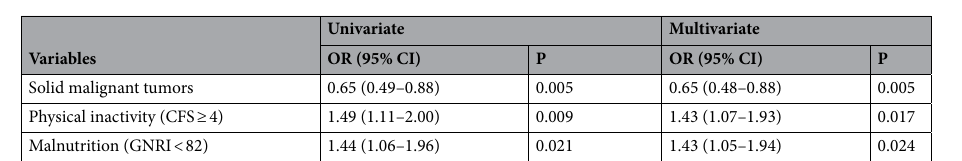
Figure 2. ( A ) Survival according to phenotypes of frailty. There was a significant difference in the cumulative survival possibility among the four phenotypes. ( B ) Home discharge according to phenotypes of frailty. There was a significant difference in the cumulative home discharge possibility among the four phenotypes.